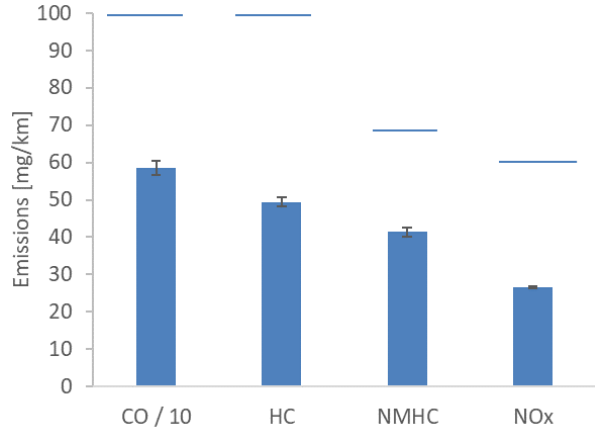
Fig. 4. Emission results of regulated pollutants. Blue bars give the motor- cycle Euro 5 limits. Error bars show min-max of two repetitions. CO emissions and emission limit are divided with 10